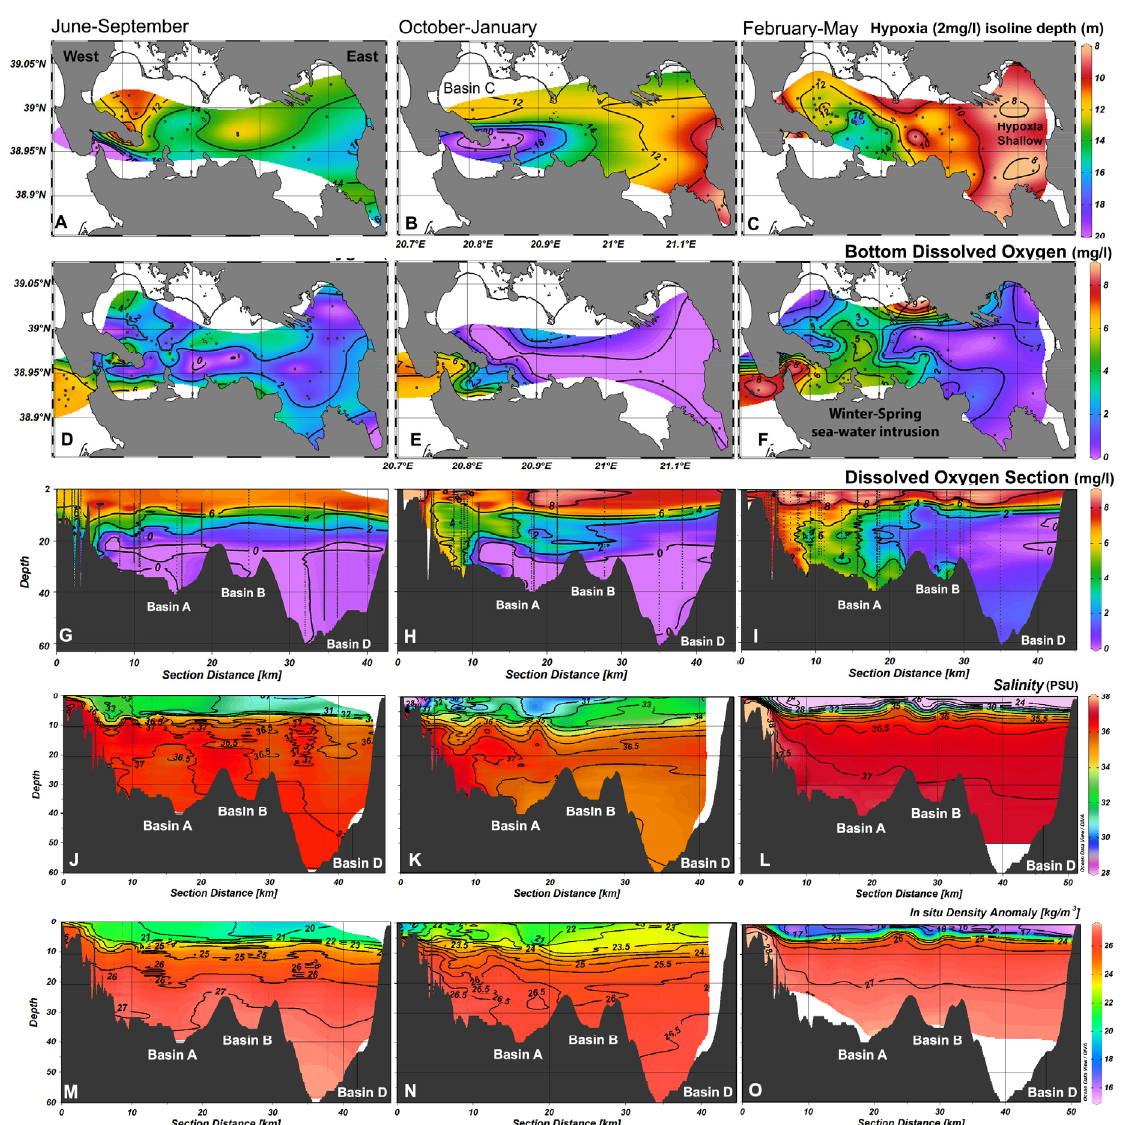
Figure 6. ( A – C ) seasonal fluctuation of the hypoxia isoline (DO:2 mg/L) depth seasonally, ( D – F ) seasonal DO concentration in mg/L at the bottom of the gulf, ( G – I ) longitudinal sections of the gulf showing the seasonal DO distribution, ( J – L ) longitudinal sections of the gulf showing the salinity distribution, and ( M – O ) longitudinal sections of the gulf showing the salinity